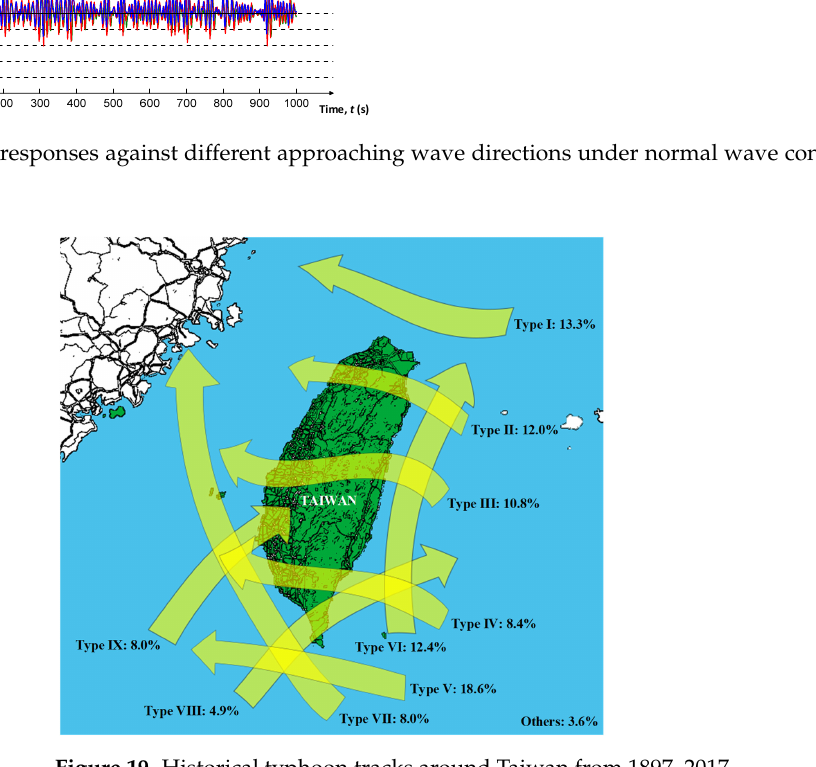
Figure 20. Waveform of JONSWAP spectrum under storm wave condition.